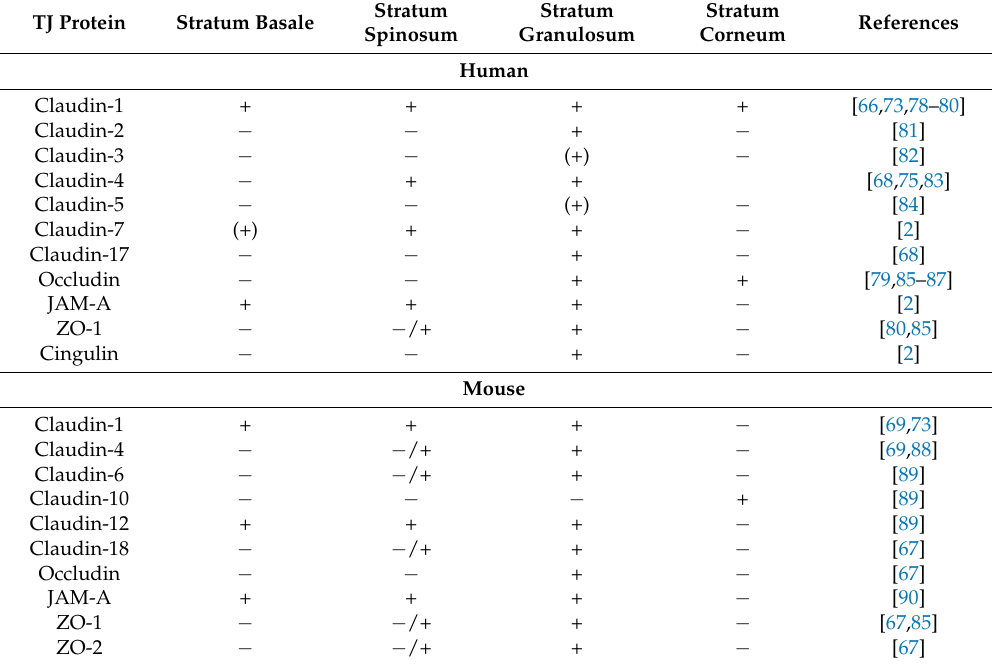
Table 1. Distribution of bi-cellular tight junction proteins in the human and mouse skin epidermis. TJ